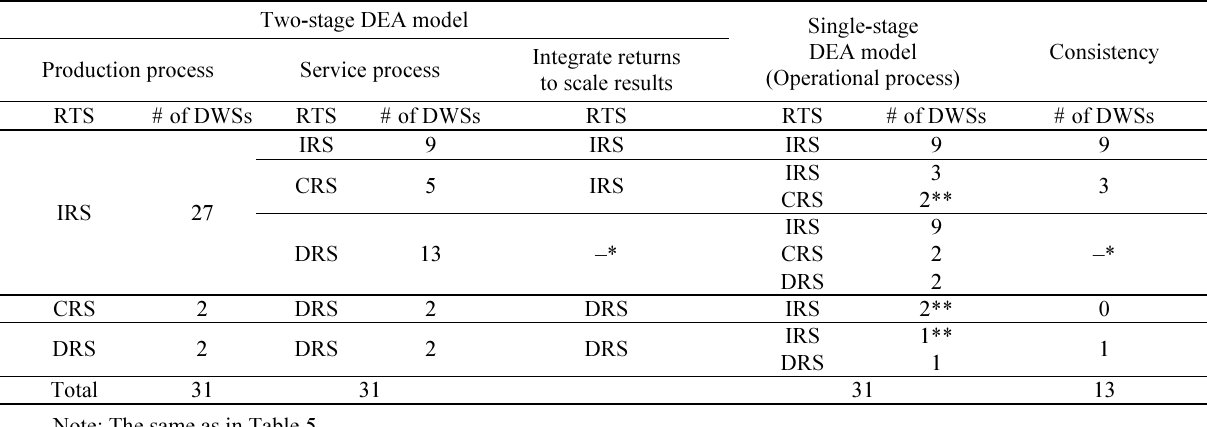
Table 6. RTS Comparisons of the two-stage and single-stage